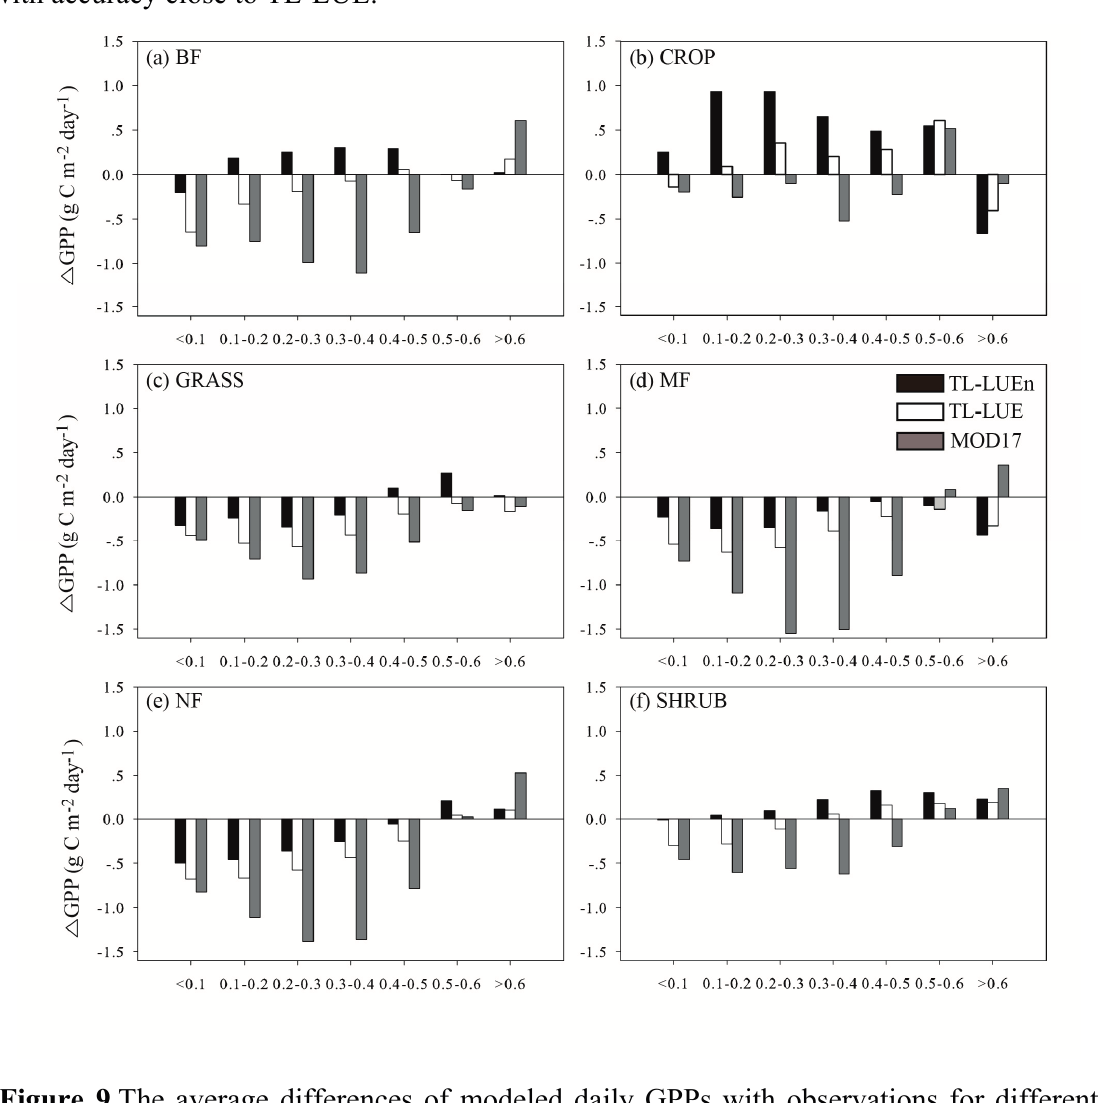
Figure 9. The average differences of modeled daily GPPs with observations for different ranges of clearness index Q . Δ GPP means the difference between the simulated and tower- derived daily GPP for certain biome. ( a – f ) denote Δ GPP for 6 different vegetation types (BF, CROP, GRASS, MF, NF and SHRUB),